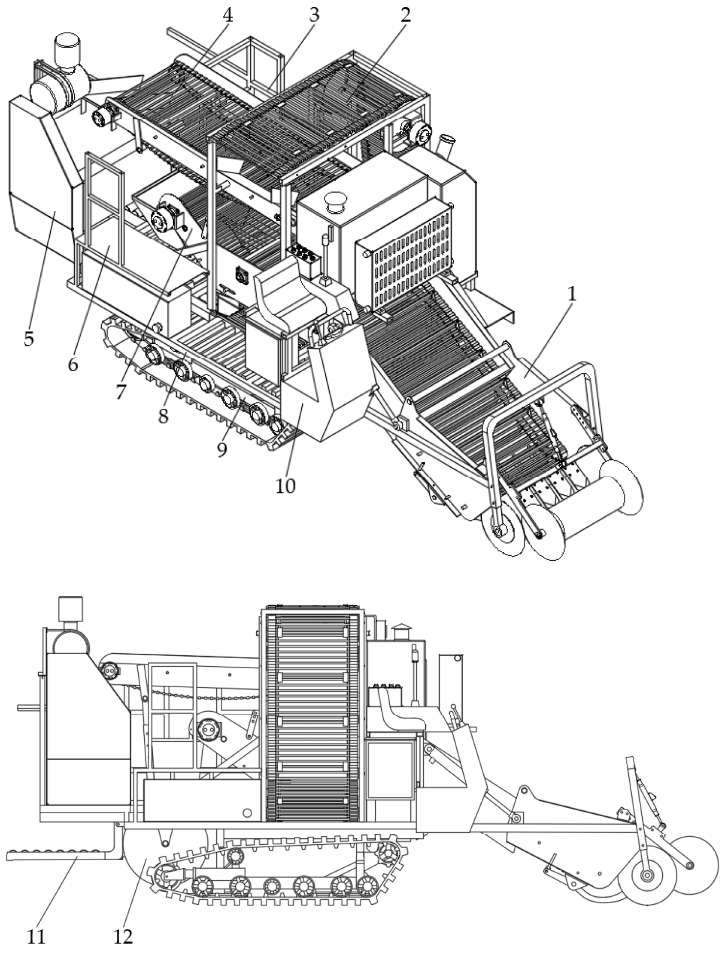
Figure 2. Perspective view and side view of the self-propelled machine for combined potato harvesting and residual plastic film retrieval: 1—digging and lifting device; 2—circulating and lifting device; 3—platform I; 4—manual sorting platform; 5—engine assembly; 6—platform II; 7—potato–